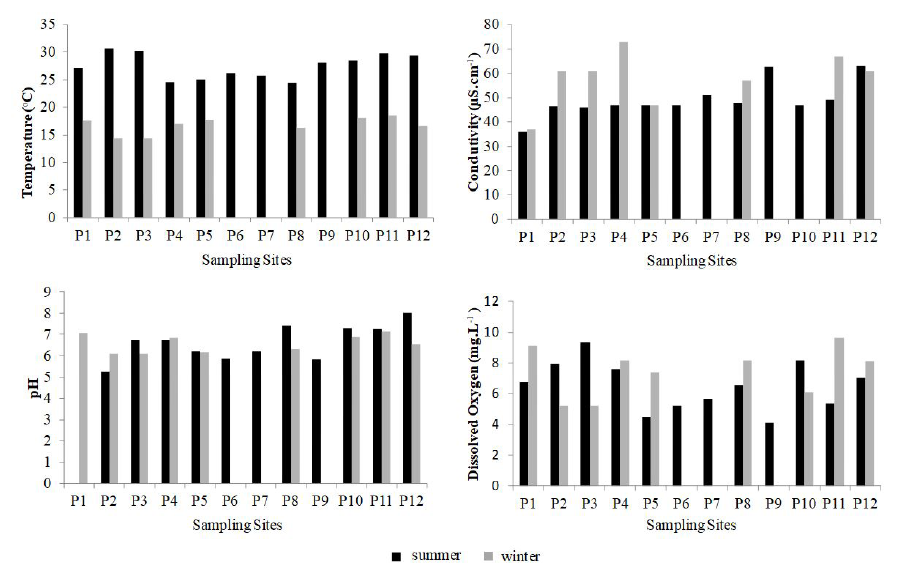
Figure 3. Variation of pH values, electrical conductivity (µS cm -1 ), water temperature (ºC) and concentration of dissolved oxygen (mg L -1 ) at different sampling sites of the Itupararanga Reservoir in two seasons (summer and winter) in 2010. There were no measurements in the sampling sites with absence of macrophytes (in the winter P6, P7 and P9). Some values were missed in the summer due to the low accessibility to the sampling